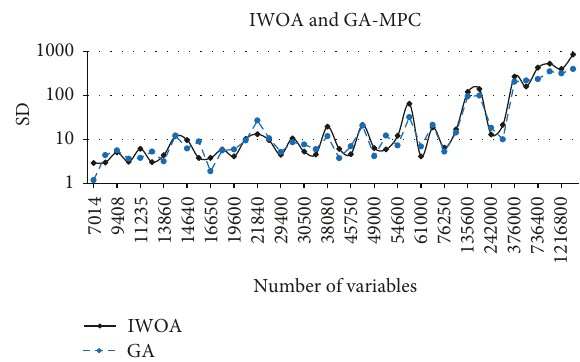
Figure 12: SD comparison of IWOA with GA-MPC for large-scale instances.